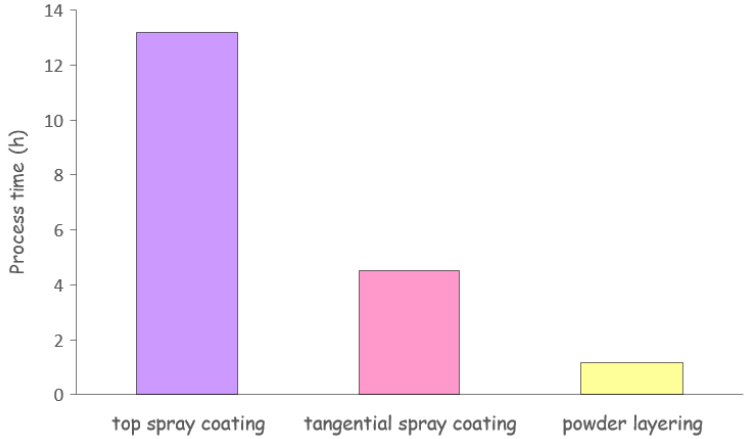
Figure 23. Process times for application of Methocel ® E50 to 50% weight gain by different coating techniques.